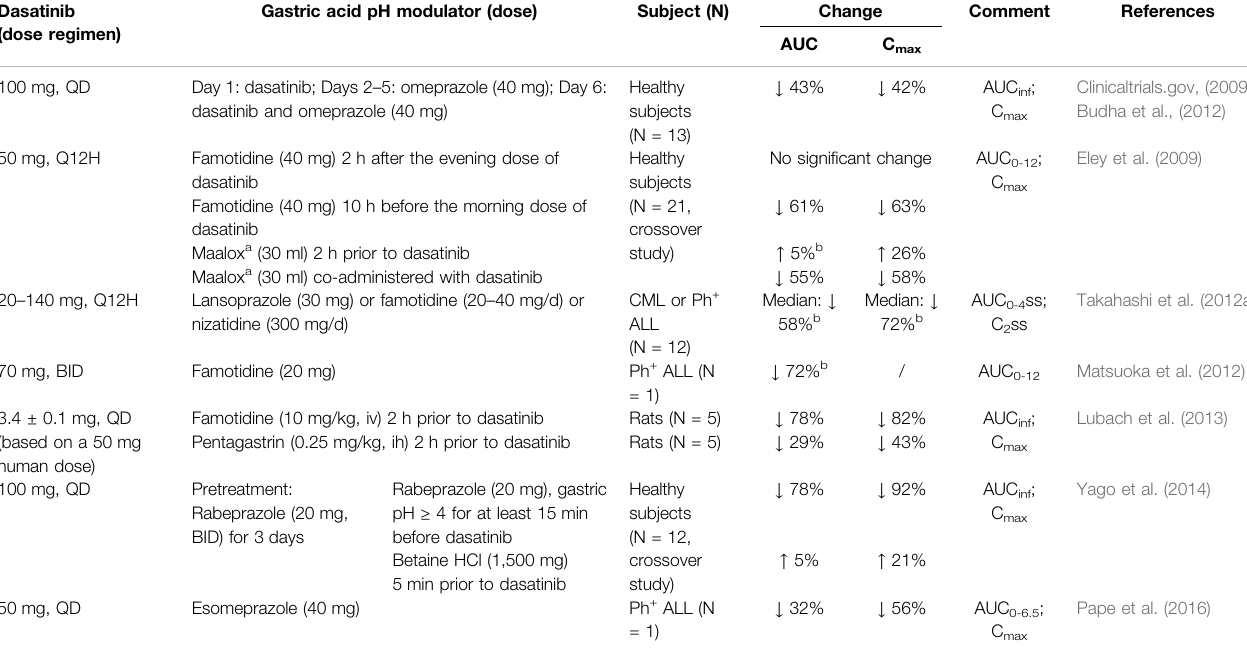
TABLE 1 | Effect of gastric acid pH modulators on the oral absorption of dasatinib. Dasatinib Gastric acid pH modulator (dose regimen)